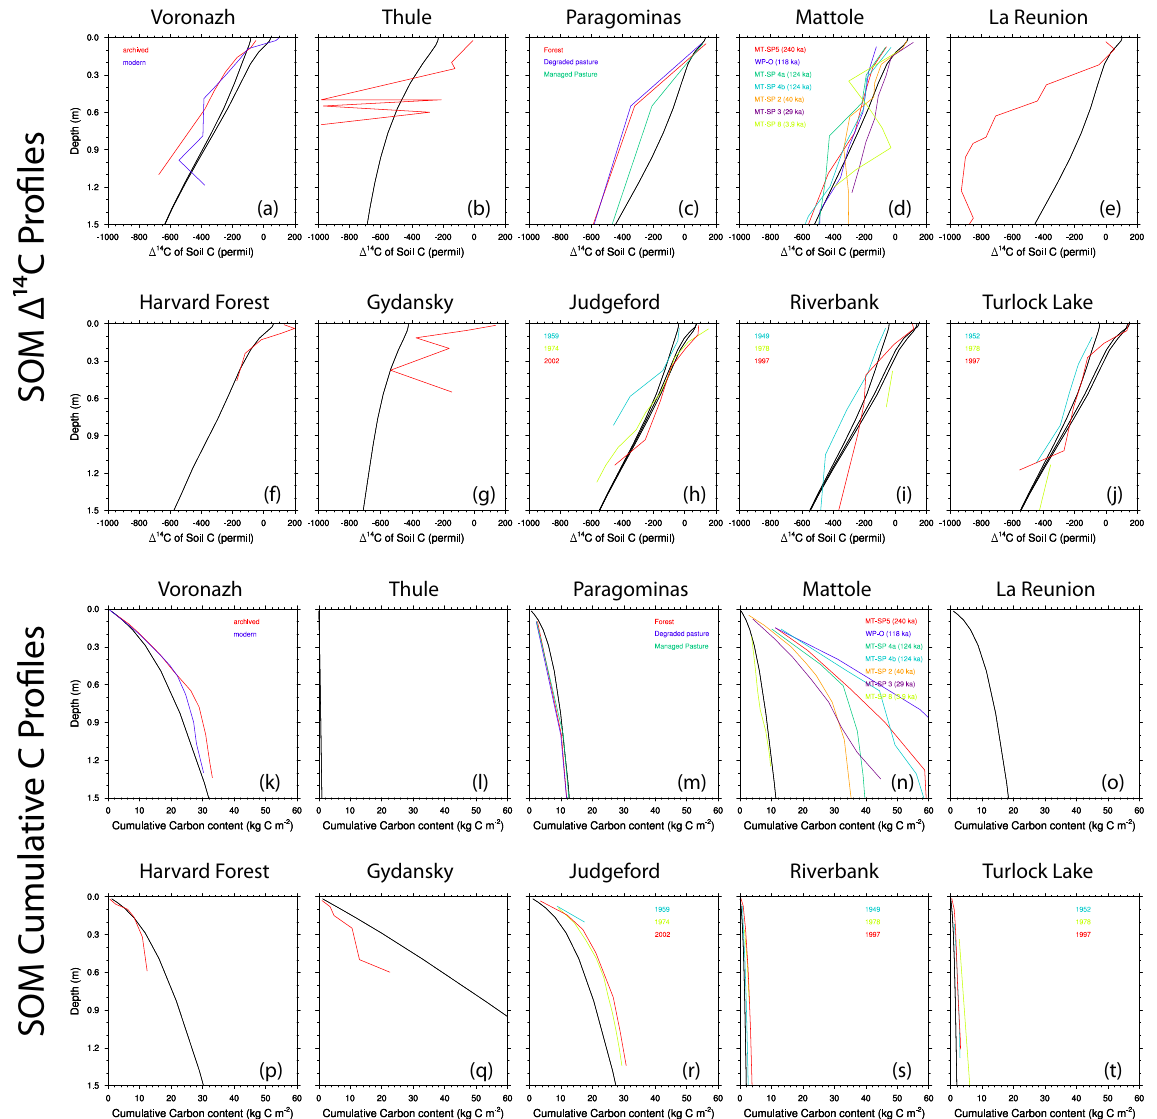
Fig. 10. Vertical profiles of soil C and 1 14 C for select sites: (a, k) Voronazh, Russia ( Torn et al., 2002); (b, l) Thule, Greenland (Horwath et al., 2008); (c, m) Paragominas, Brazil (Trumbore et al., 1995); (d, n) Mattole, California (Masiello et al., 2004); (e, o) La Reunion, South Pacific (Basile-Doelsch et al., 2005); (f, p) Harvard Forest, Massachusetts (Gaudinski et al., 2000); (g, q) Gydansky, Western Siberia (Kaiser et al., 2007); and (h, r) Judgeford, New Zealand; (i, s) Riverbank, California; and (j, t) Turlock Lake, California (Baisden and Parfitt, 2007). For all figures, black line is model, and colored lines are observations. Some of the sites have multiple profiles, due to multiple soil ages (Mattole), multiple land-use types (Paragominas), and multiple sampling dates (Voronazh, Judgeford, Riverbank, and Turlock Lake). For those sites with multiple sampling dates, multiple model profiles are shown corresponding to the years of the soil sampling